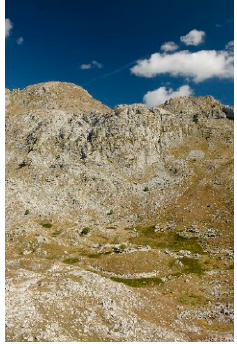
Figure 6. Katun in the cirque—Gropa Beljeva, photo: I. Lakovi ć .